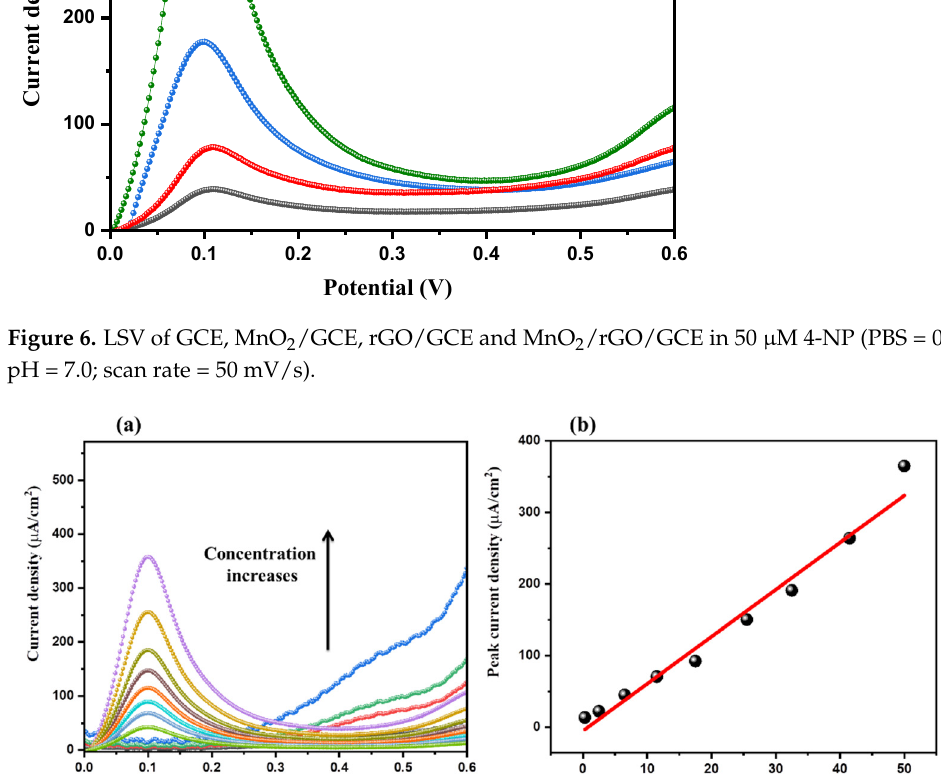
Figure 6. LSV of GCE, MnO 2 /GCE, rGO/GCE and MnO 2 /rGO/GCE in 50 µM 4-NP (PBS = 0.1 M; pH = 7.0; scan rate = 50 mV/s).